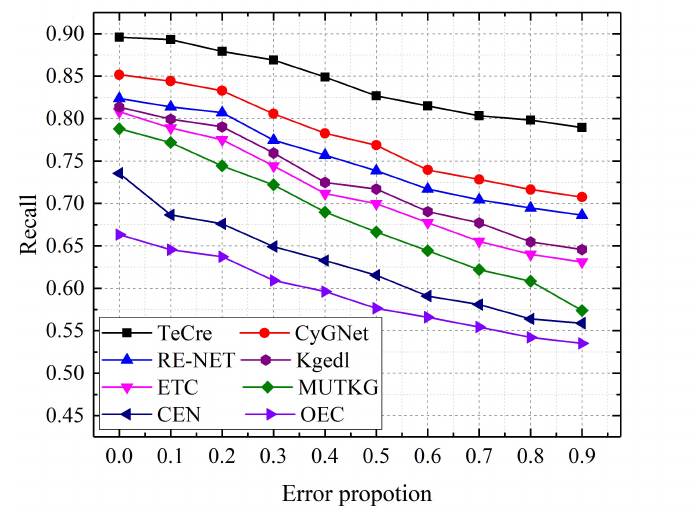
Figure 8. Recall on YAGO15K with different error proportion.